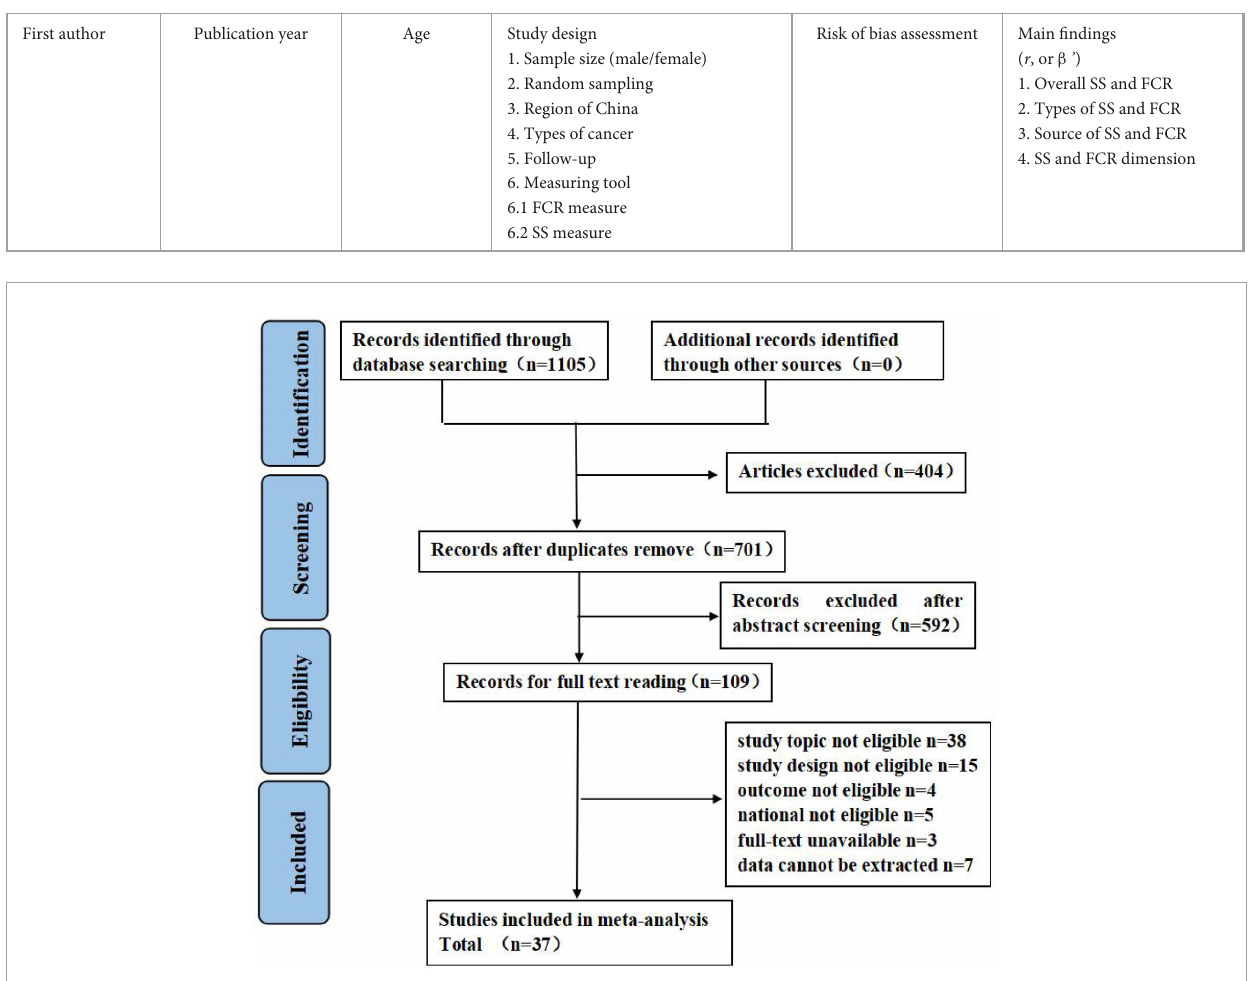
FIGURE1 Flow diagram of literature search. Adapted from Page et al. (45) licensed under CC-BY 4.0.